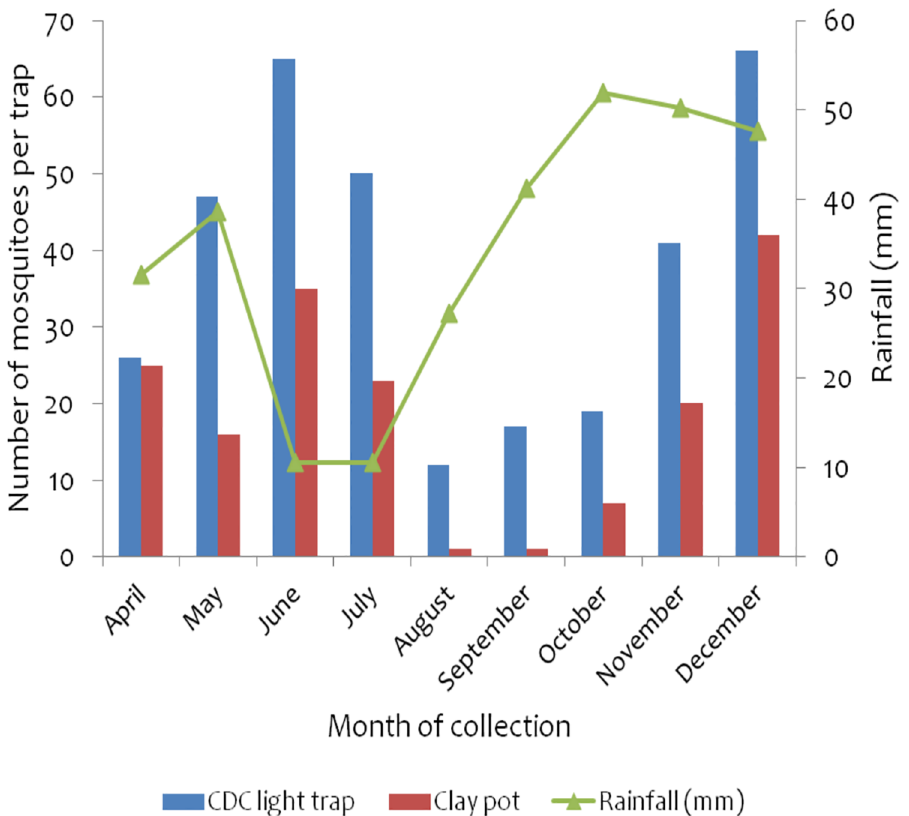
Fig 8. Monthly collection of anopheline mosquitoes in Ochuna village, Rorya district monitored using CDC light traps and clay pot methods. The rainfalldata was obtainedfrom climate data library (http://iridl.